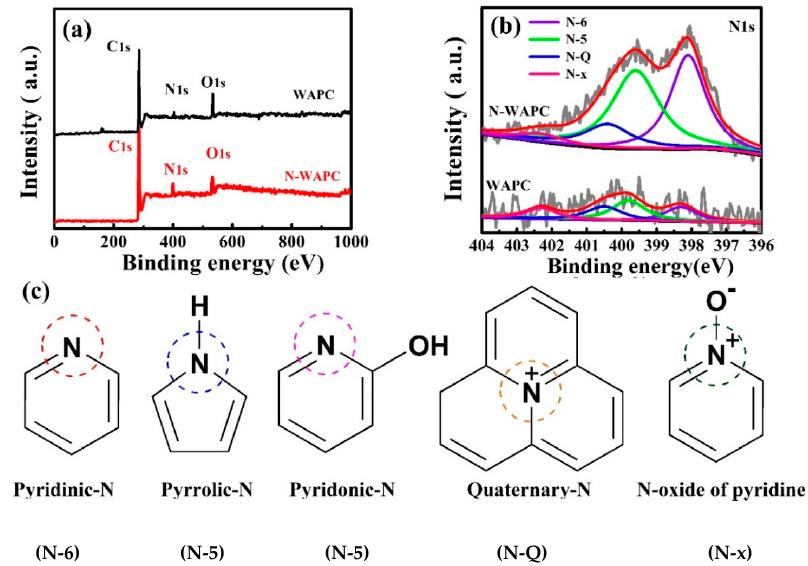
Figure 4. XPS for WAPC and N-WAPC ( a ) full-survey spectra and ( b ) high-resolution spectra of N1s; ( c ) the different N species possibly present in the porous carbons.